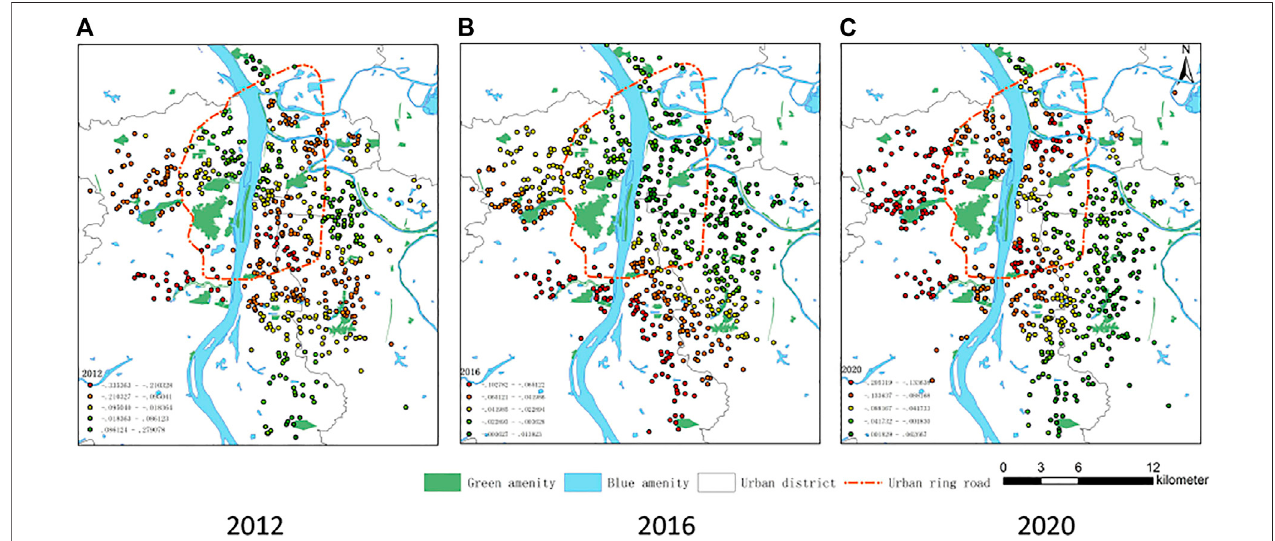
FIGURE 7 | Spatial and temporal variation of XR in fl uence coef fi cients in 2012, 2016 and 2020.